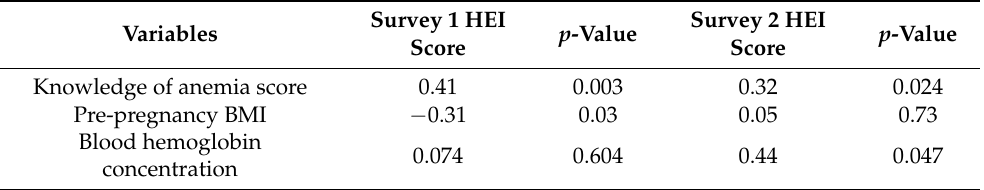
Table 7. Correlation coefficients ( r ) for HEI scores and the variables examined.